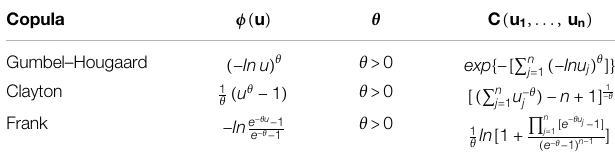
TABLE 1 | List of common Archimedean copula function. Copula ϕ ( u ) θ C ( u 1 , ... , u n ) Gumbel –